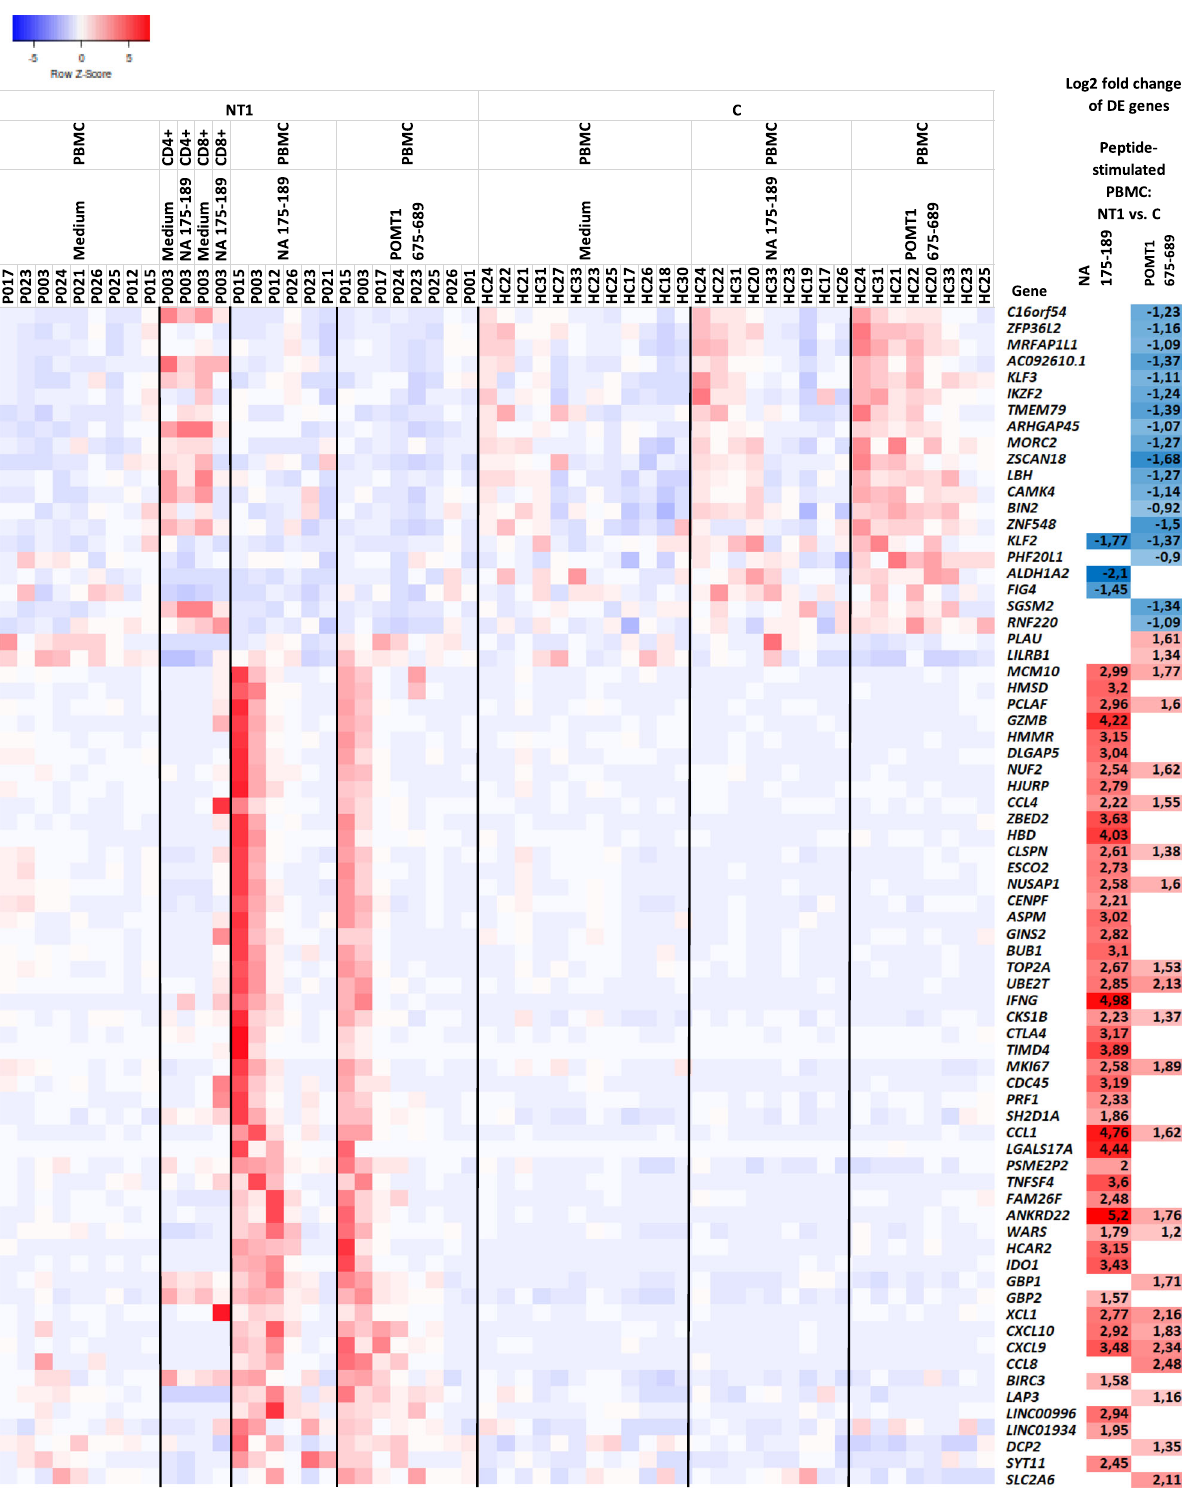
Fig. 6 Gene expression pro fi ling by RNA-seq of peptide-stimulated PBMC from Pandemrix-associated NT1 patients. Hierarchically clustered heatmap of the gene expression levels ( z -score scaling generated with the Heatmapper program) in all tested PBMC samples for 74 genes showing signi fi cant differences in expression (** p < 0.01) between NT1 patients and controls either after stimulation with NA 175 – 189 (49 genes) or POMT1 675 – 689 peptides (28 genes; overlap of 3). Differentially expressed genes were identi fi ed using edgeR, based on a test analogous to Fisher ’ s exact test. The paired method was used for comparisons, calculating 2-sided p -values and adjusting for multiple testing using BH correction. If signi fi cance was reached (* p < 0.05), log2 fold changes between NT1 patients and controls are shown on the right. Data derived from FACS-sorted CD4 + and CD8 + cells available from one NT1 patient were added for